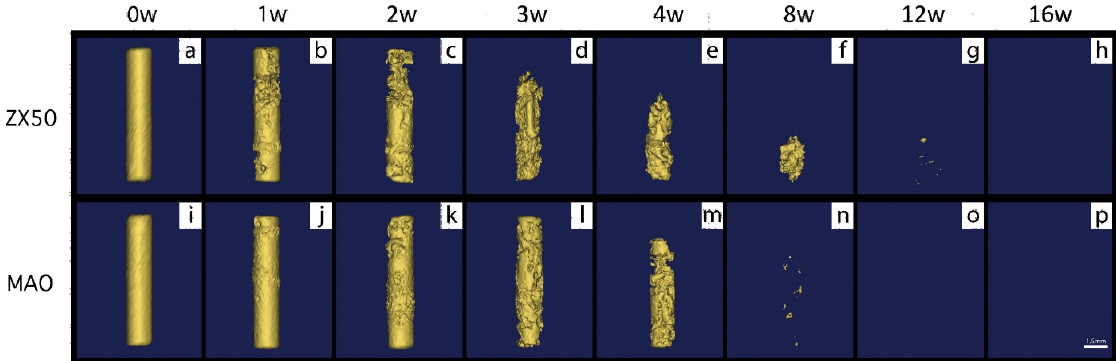
Figure 10. Micro-CT images of ( a – h ) ZX50- and ( i – p ) MAO-treated ZX50 pins after their implantation in the femoral mid-diaphyseal region of the rats for 16 weeks. Reproduced with permission from [45]. Copyright 2016, Elsevier.